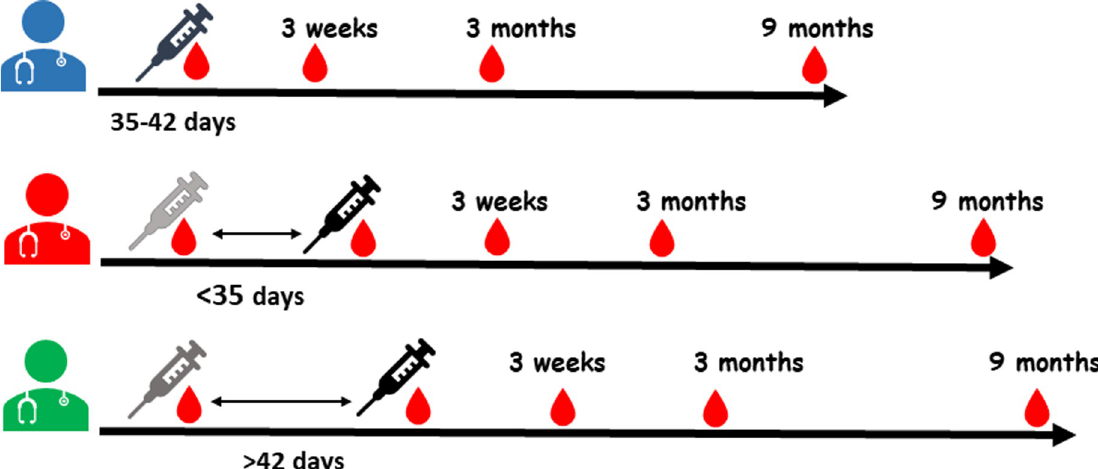
Fig 1. Study design. Three groups of healthcare workers (HCW) were recruited according to the timing of the second vaccine dose (black needle) at either < 35 days, 35–42 days or > 42 days following the first dose. Blood samples for serological tests were collected at the same timepoints from the second dose: at the time of the (pre-) second dose and at 3 weeks, 3 months and 6–9 months post-second dose. Baseline pre-first dose blood samples were available for the < 35 days and > 42 days groups who were recruited before the first dose, while the 35–42 days group was enrolled at the time of the second